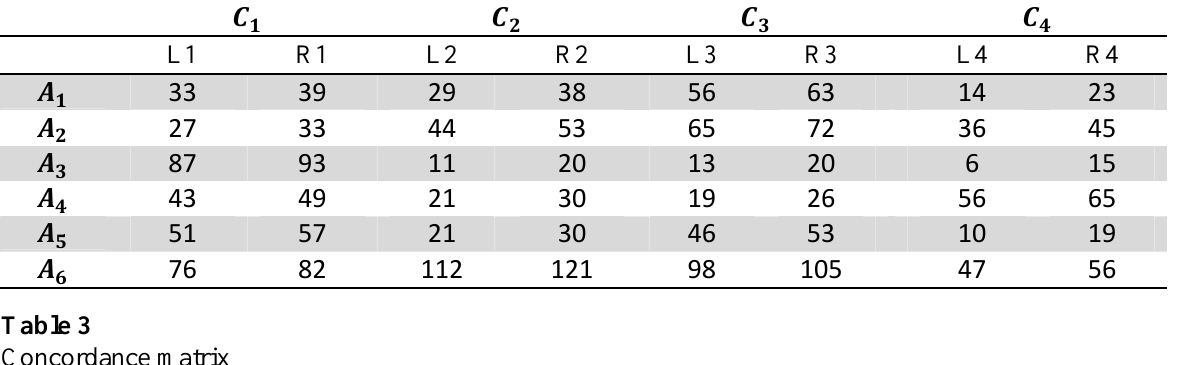
Concordance matrix Concordance